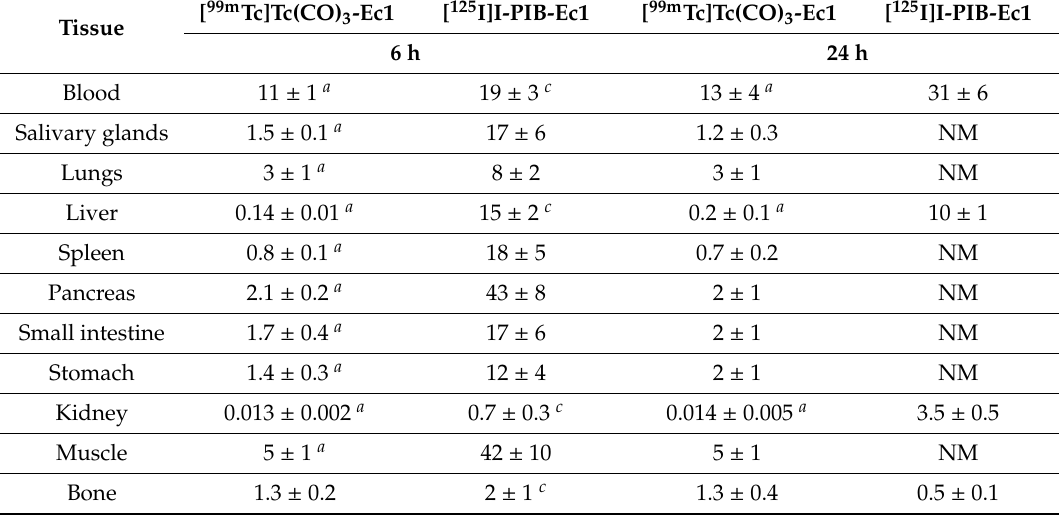
Table 5. Tumor-to-organ ratios of [ 99m Tc]Tc(CO) 3 -Ec1 and [ 125 I]I-PIB-Ec1 in Balb / C nu / nu mice bearing MDA-MB-468 xenografts at 6 and 24 h